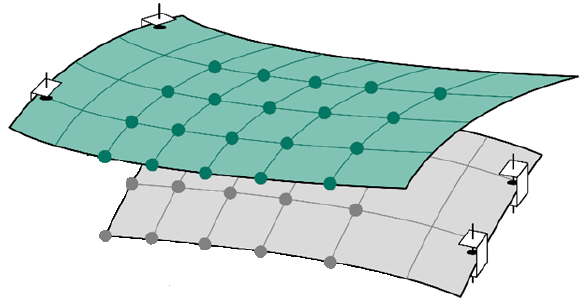
Figure 1. Illustration of the finite element model of the assembly.